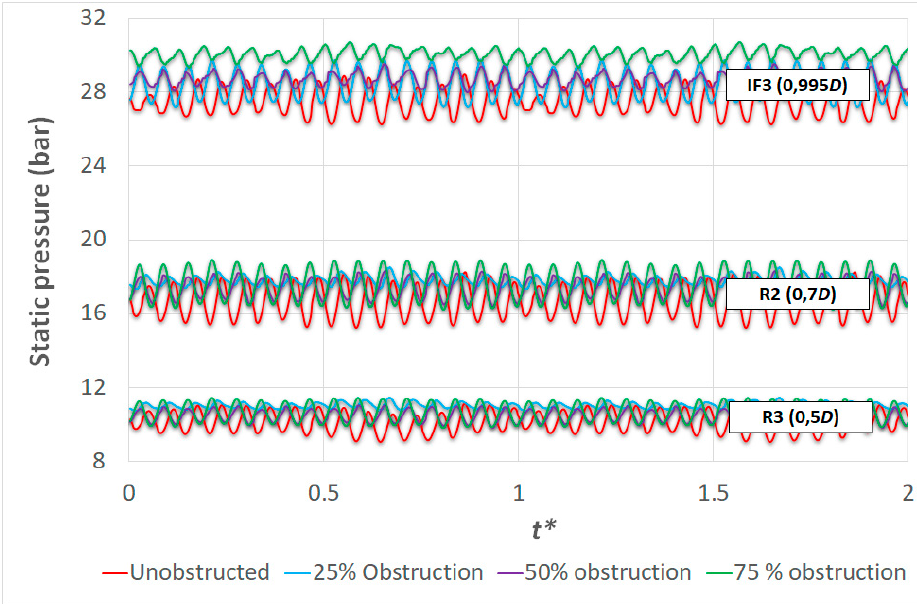
Figure 13. Pressure signal in the rotating reference frame for different rotor blockage sizes.